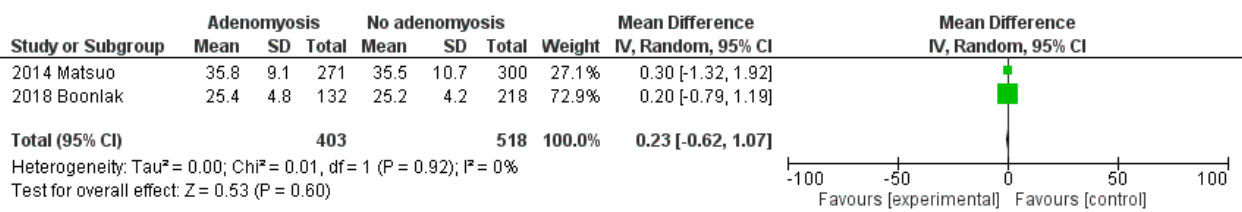
Figure 1. Forest plot of mean difference in mean ± standard deviation (SD) of age between EC patients with and without adenomyosis, for each included study and as pooled estimate.